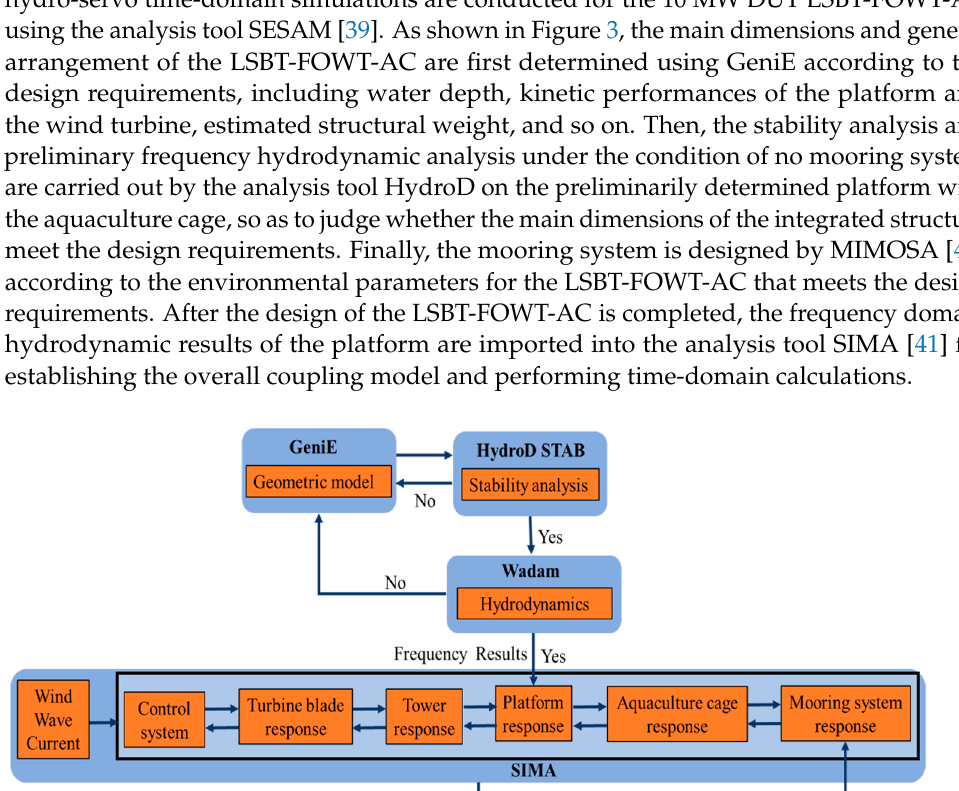
Table 1. Properties of DTU 10 MW offshore wind turbine. Parameters Value Wind Regime IEC class 1 A Cut-in wind speed (m/s)